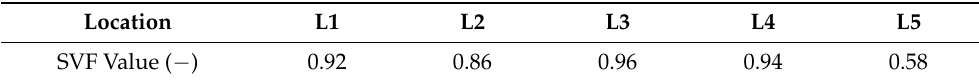
Figure 5. Photographs of the surroundings at locations (L1–L5), taken using a fisheye lens. Table 5. The SVF values determined for the locations